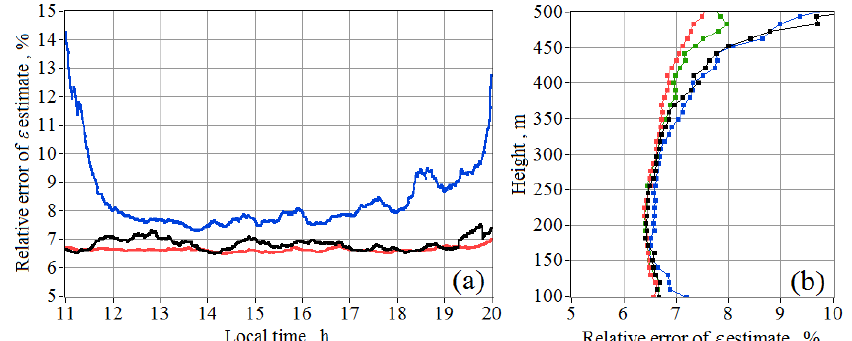
Figure 13. Time series of the relative error of estimation of the turbulence energy dissipation rate (a) at heights of 100m (black curve), 300m (red curve), and 500m (blue curve), and height profiles of the relative error of estimation of the turbulence energy dissipation rate (b) at 11:30LT (black squares), 14:00LT (red squares), 17:00LT (green squares), and 19:30LT (blue squares) taken from the data of Fig.